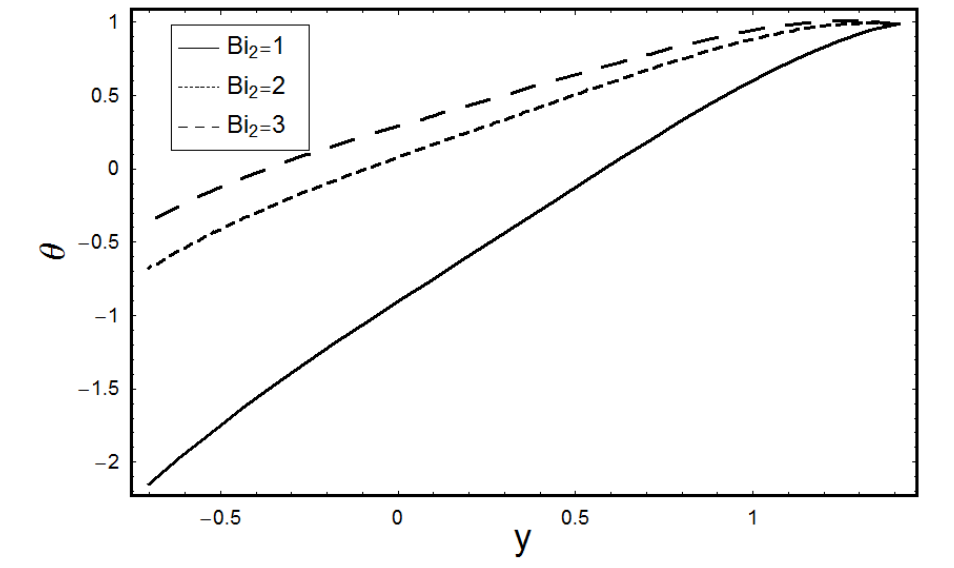
Figure 13. Variation in θ for Bi 2 with a = 0.3, b = 0.3, d = 0.6, φ = π /4, Θ = 1, x = 0, n = 1.5, Br = 0.5 and Bi 1 =